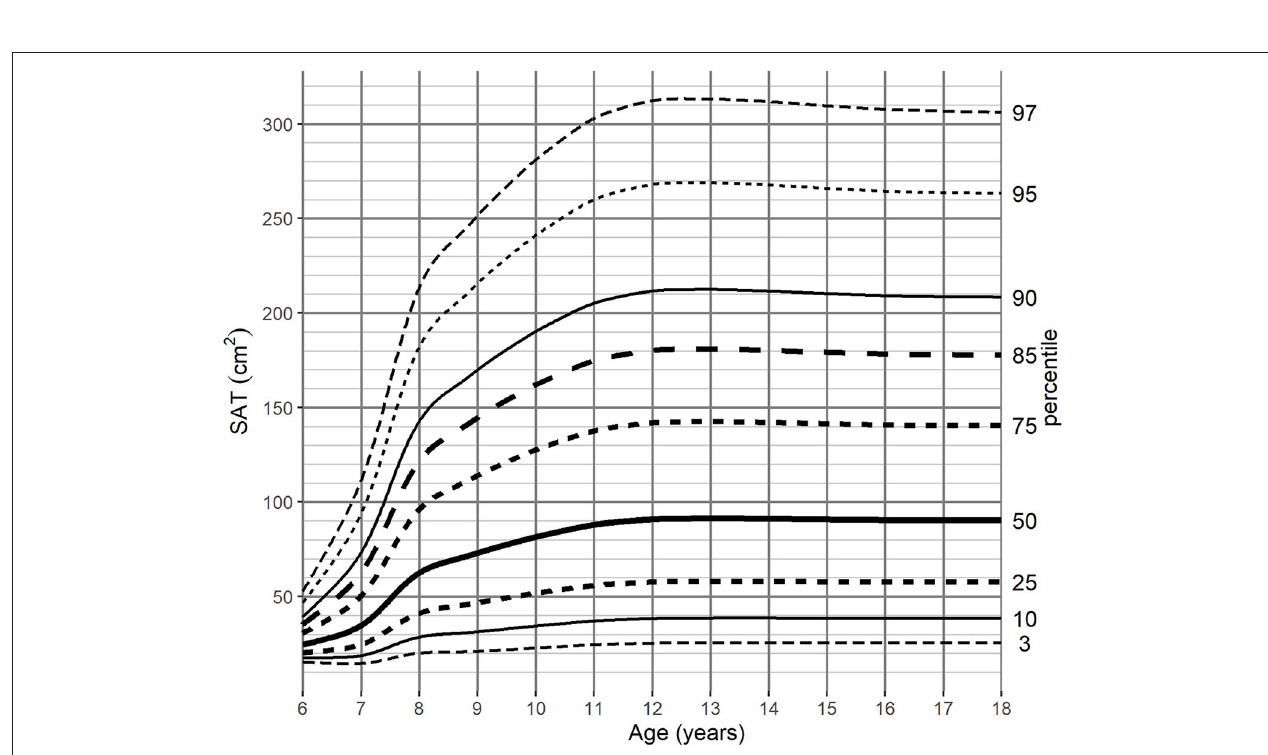
FIGURE 3 | SAT-for-age (cm 2 ) percentile charts for girls aged from 6 to 18 years. SAT, subcutaneous adipose tissue.